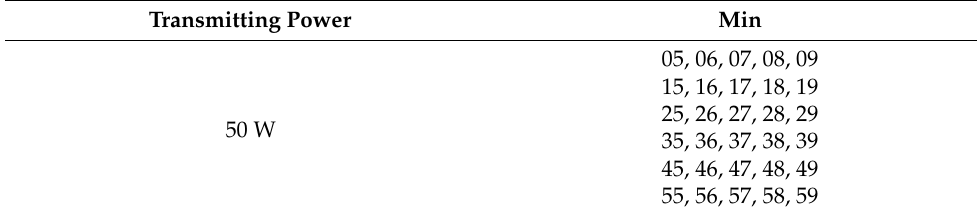
Table 2. Experiment for the second data frame (see Figure